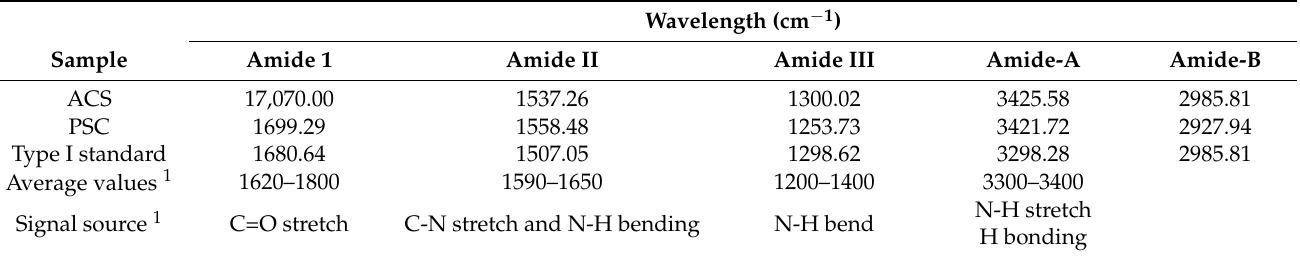
Table 3. Functional groups obtained from FTIR of acid-solubilized collagen (ASC) and pepsin- solubilized collagen (PSC) from catfish skin and type I collagen